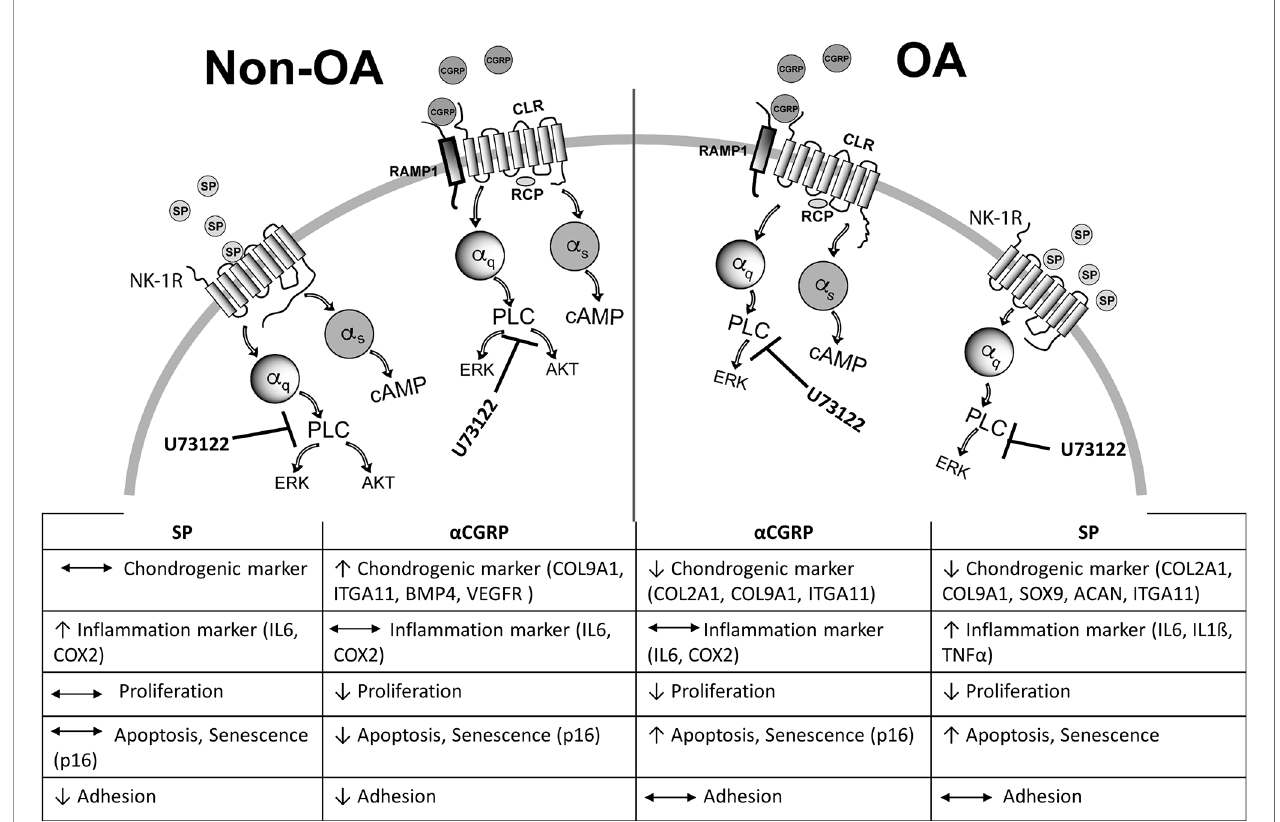
FIGURE 8 | Schematic summary of SP and a CGRP metabolic effects and activated signaling pathways in healthy and OA chondrocytes. Binding of SP and a CGRP to their respective receptors results in different physiological effects in OA- and healthy chondrocytes presumably due to activation of partly different signalling pathways in both chondrocyte